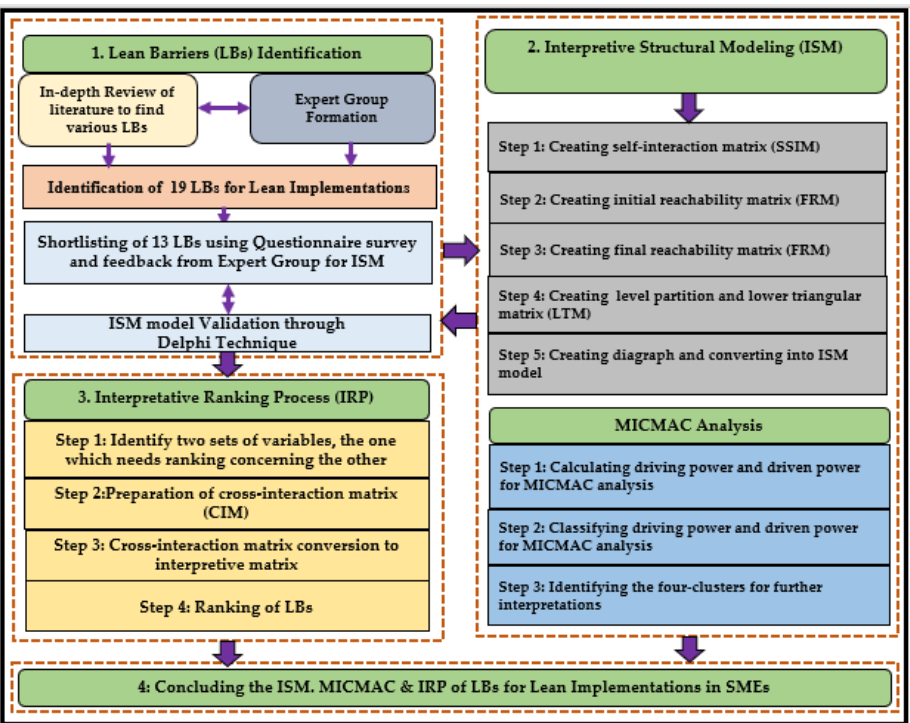
Figure 1. The research methodology.